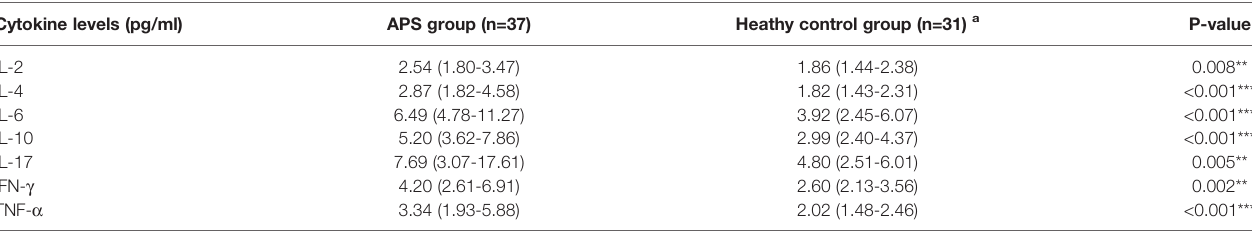
TABLE 2 | Cytokine levels (pg/ml) in APS group and heathy control group. Cytokine levels (pg/ml)